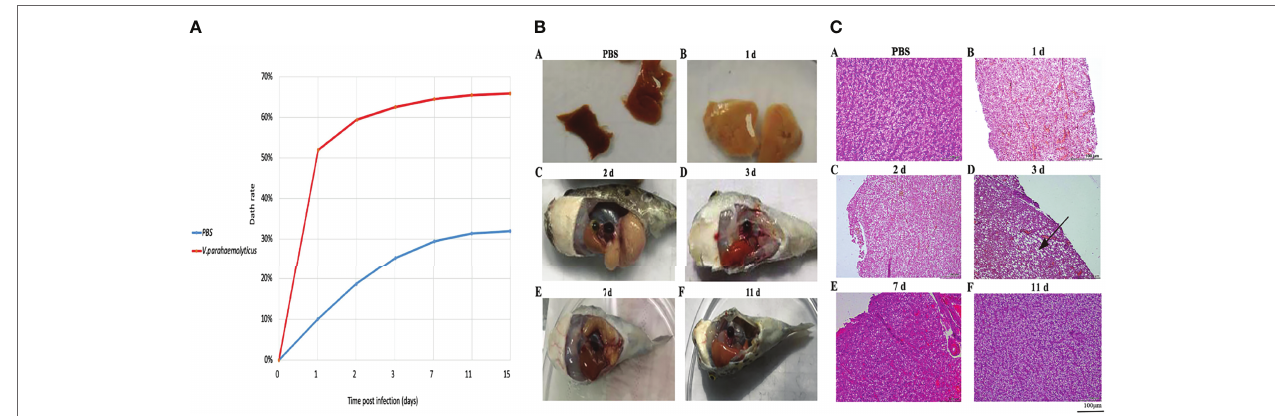
FIGURE 1 | V. parahaemolyticus infection to T. nigroviridis. (A) The mortality rate of T. nigroviridis after V. parahaemolyticus infection. (B) Morphological changes of T.nigroviridis livers. (A) The control group (injected with PBS; (B) 1 dpi; (C) 2 dpi; (D) 3 dpi; (E) 7 dpi; (F) 11 dpi. (C) Histopathological examination of T.nigroviridis livers (magnification, ×100). (A) The control group; (B) 1 dpi; (C) 2 dpi; (D) 3 dpi; (E) 7 dpi; (F) 11 dpi. Black arrow points to fat